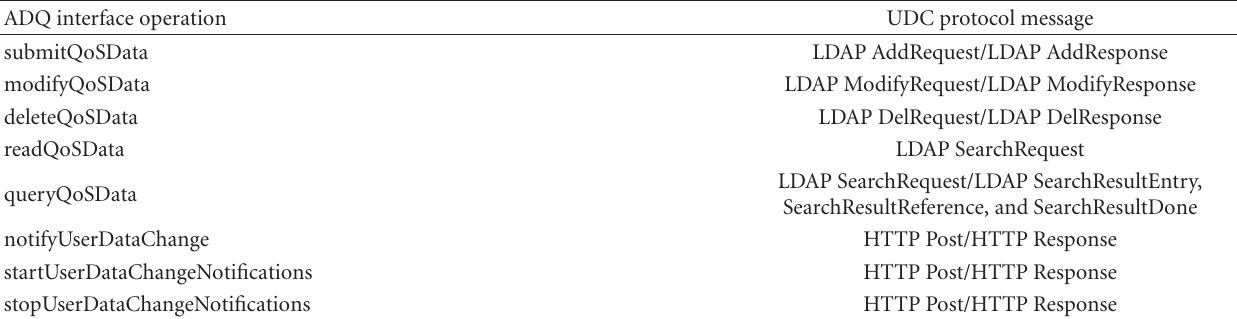
Figure 7: Use case of location-based charging. Table 4: Mapping overview of the suggested ADQ interfaces onto UDC